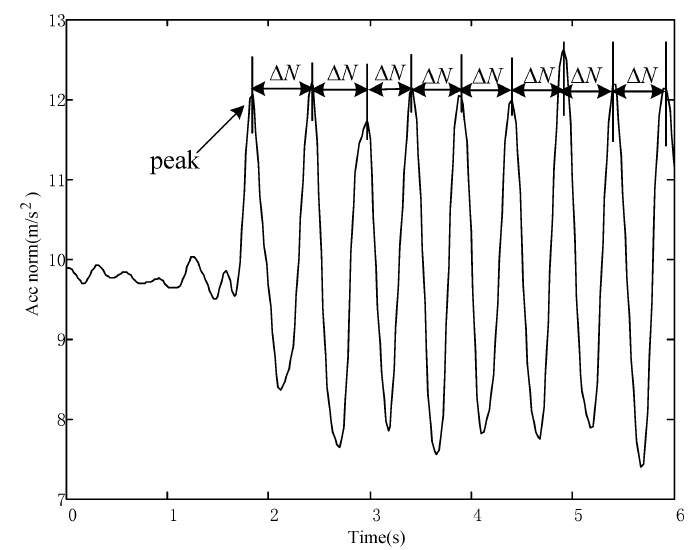
Figure 4. Modulus values of the